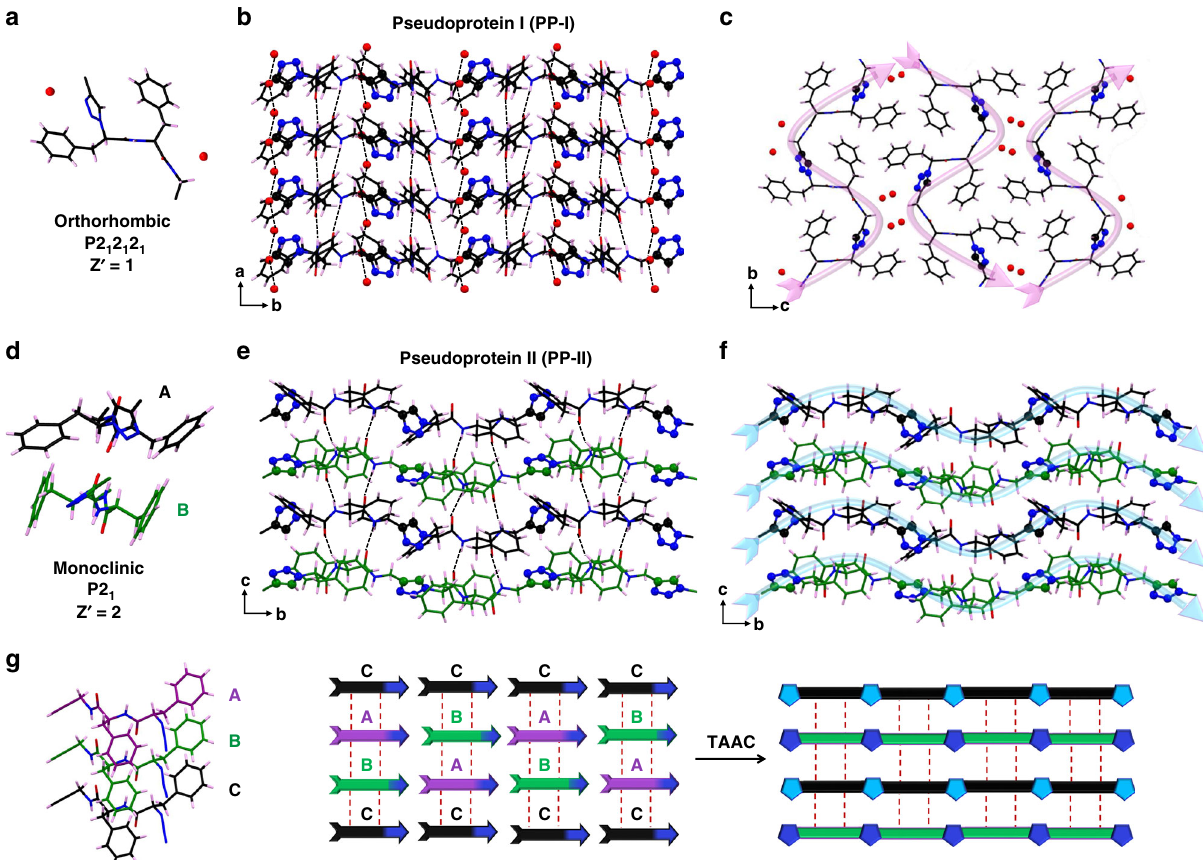
Fig. 4 Structures of the pseudoproteins. a Crystal structure of PP-I showing the presence of two water molecules in the asymmetric unit. b β -sheet hydrogen bonding in PP-I and one-dimensional water wire. c Pseudoprotein packing in PP-I showing water molecules in the channels. d Crystal structure of PP-II showing two symmetry-independent molecules in the asymmetric unit. e β -sheet hydrogen bonding in the PP-II. f Two dissimilar polymer chains in the PP-II with their phenyl rings placed between the β -strands. g Schematic showing the TAAC reaction in DP-II leading to two conformationally dissimilar polymer chains in